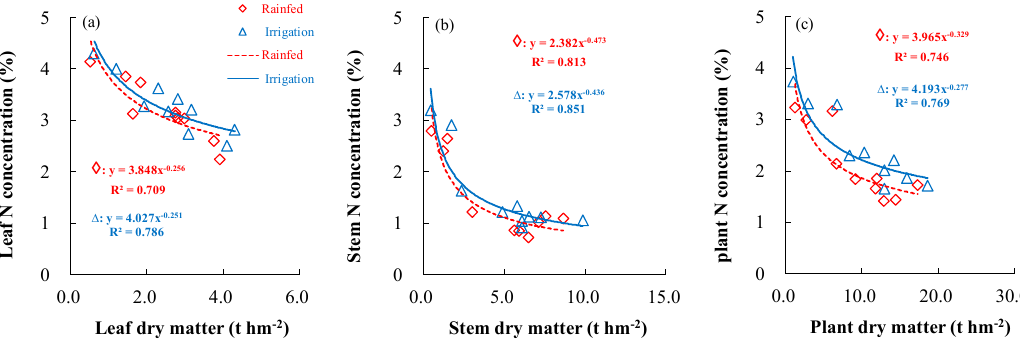
Figure 4. Critical N concentration dilution curves in wheat leaves, stems, and the whole plant under different irrigation conditions in Shangshui. The datasets are from Exp. 3 and 4.